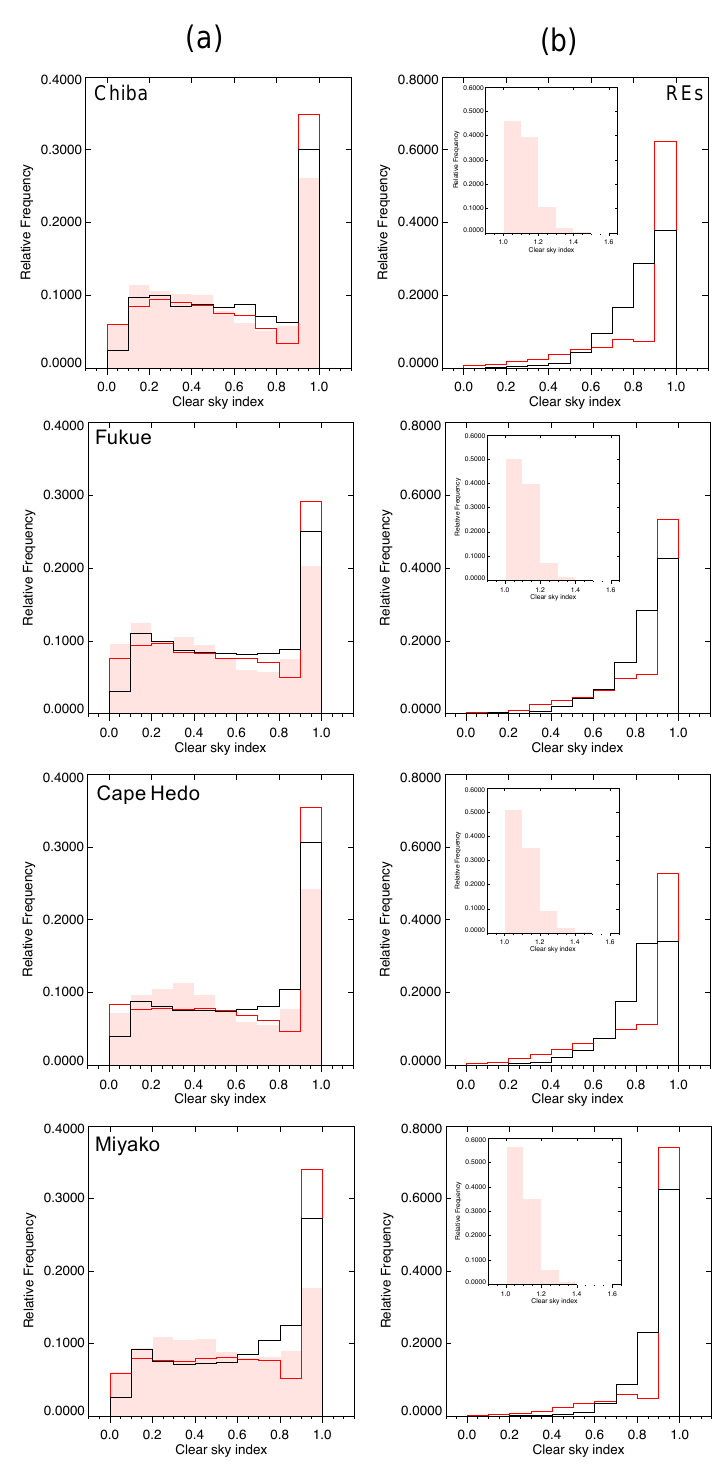
Figure 6. (a) Distribution of the CSI based on ground-based SKYNET observations (pink area) and Himawari-8 estimates at the pixel level (red line) and within a 5km spatial domain (black line) for the different SKYNET stations. (b) Main panel: distribution of the CSI based on Himawari-8 estimates as panel (a) but only for RE events. Inset: distribution of the CSI based on SKYNET observations but only for RE events. Time step: 2.5min. See text for further